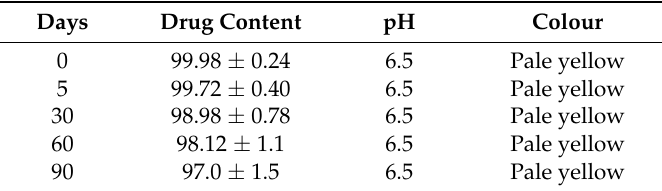
Table 4. Stability assessment data of Quercetin nanoemulgel.